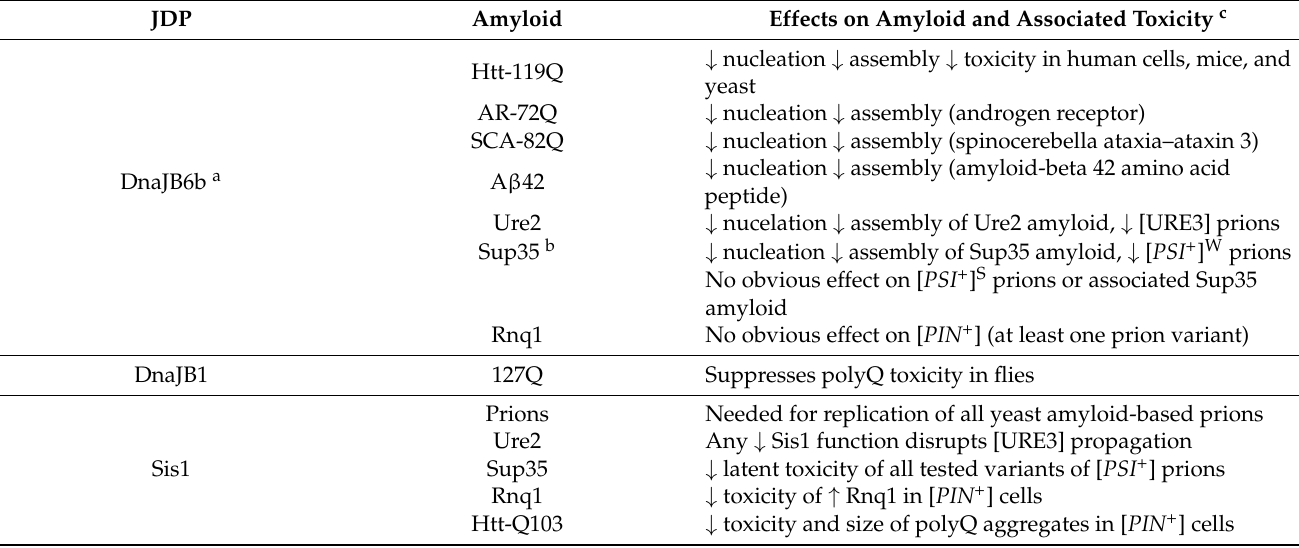
Table 1. Effects of JDPs on amyloid and amyloid-associated